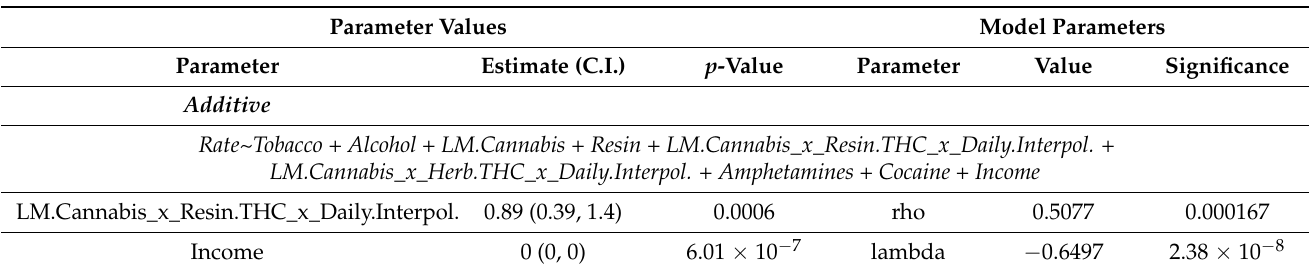
Table 4. Geospatiotemporal Models for Diaphragmatic